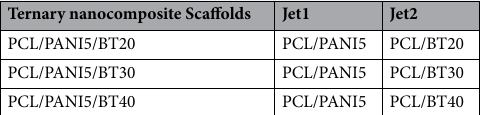
Table 2. Different combination of electrospun PCL/PANI5 and PCL/BT in dual jet electrospinning.